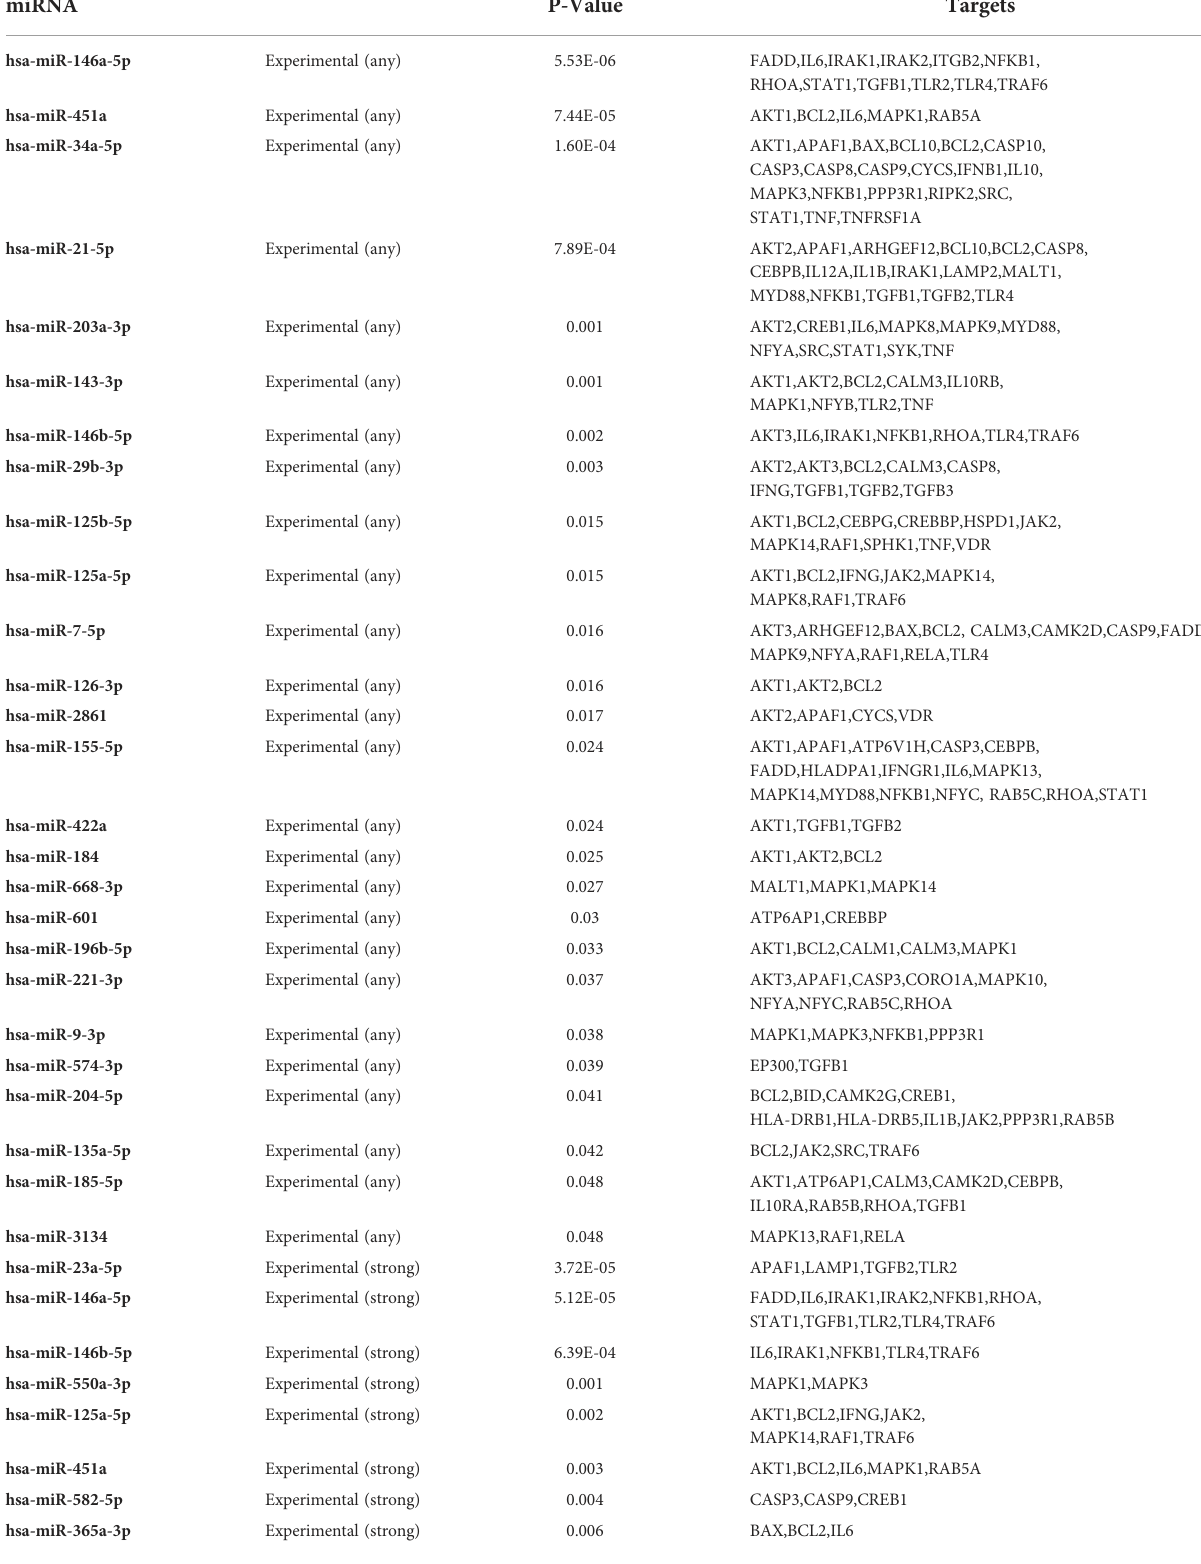
TABLE 2 miRNAs associated with regulating the various signaling pathways (Source miRbase